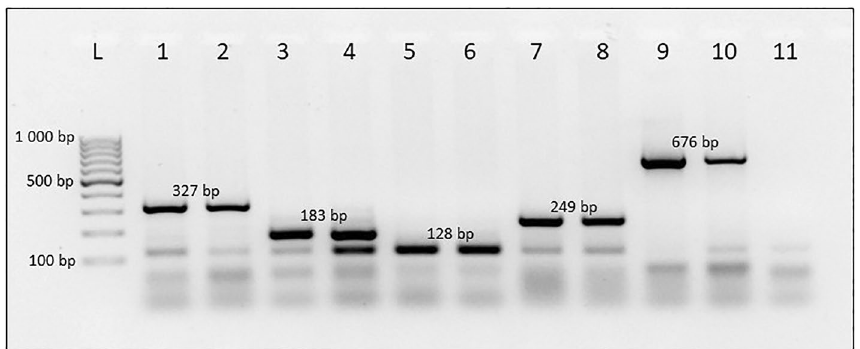
Figure 2. 2% Agarose-TAE gel displaying the specificity of multiplex primers in the case of duplex formation in freshly extracted colony-reared larval DNA with species-specific amplicon size indicated. Lane 4 demonstrates the expected C. cosyra amplicon at 183 bp with non-specific amplification at 128 bp leading to the formation of a duplex; the larger 183 bp amplicon should be used for identification. Lane 5 is a single 128 bp amplicon indicative of C. quilicii . Lanes 1 & 2: C. capitata , Lanes 3 & 4: C. cosyra , Lanes 5 & 6: C. quilicii , Lanes 7 & 8: C. rosa , Lanes 9 & 10: B. dorsalis , Lane 11: No template control, Lane L: GeneRuler 100 bp DNA ladder (Thermo Scientific). The original gel is presented in Supplementary Fig.